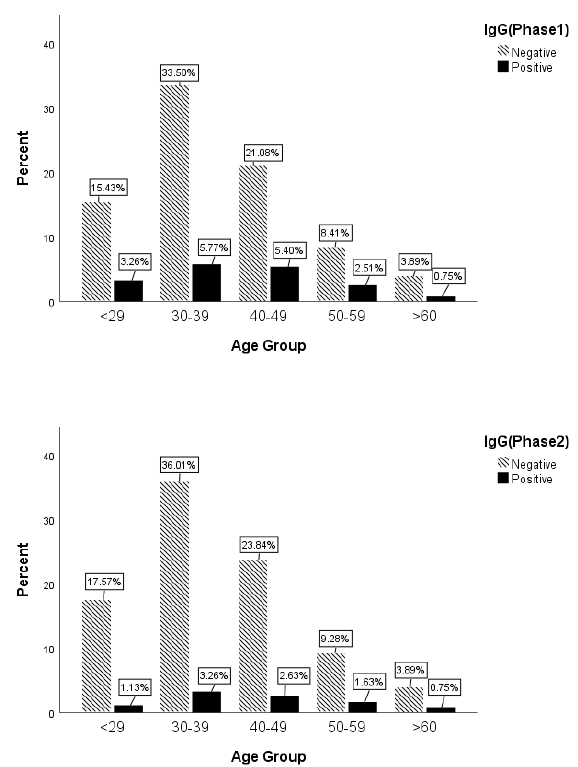
Figure 4. (a) Seroprevalence of IgG in Phase 1 Stratified by the Age Group. (b). Seroprevalence of IgG in Phase 2 Stratified by the Age Group. Note . IgG: Immunoglobulin